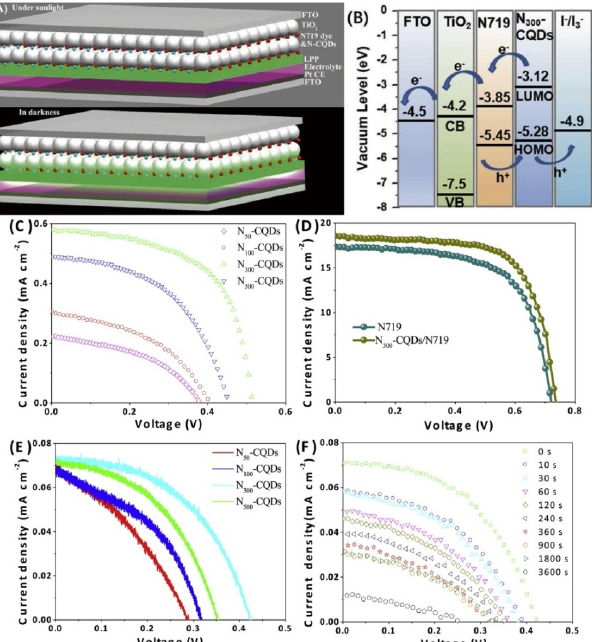
Figure 15. ( A ) Schematic diagram of the N300-CQDs and N719 co-sensitized DSSCs with a m- TiO2/LPP photoanode. ( B ) Energy level distribution and charge transfer processes at photoanode/electrolyte interface. Representative photo J-V characteristics of the solar cells sensitized by ( C ) various N-CQDs and ( D ) N719 dye and N300-CQDs/N719 under simulation solar irradiation (100 mWcm − 2 , AM 1.5), and ( E ) in completely dark conditions. ( F ) Dark J-V curves for N300-CQDs sensitized solar cells using m-TiO2/LPP photoanode at various decay times. Reprinted with the permission of Reference [115]. Copyright 2018 Elsevier Ltd.